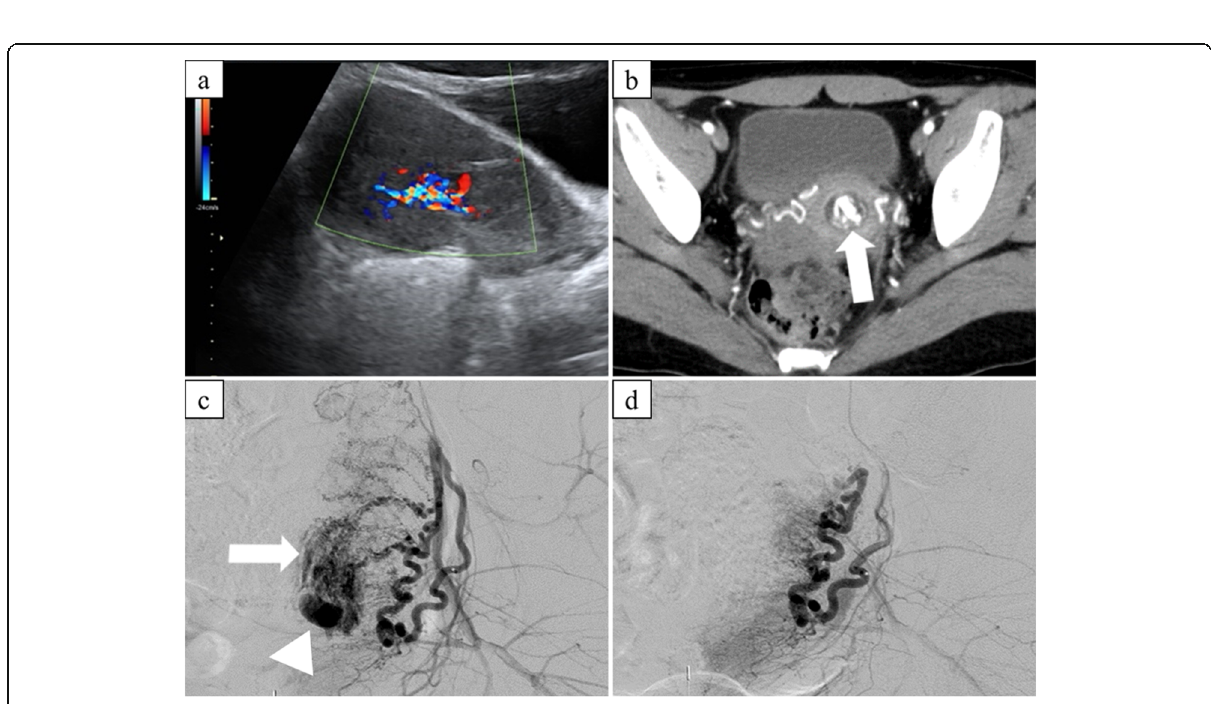
Fig. 2 32-year-old patient with vaginal bleeding post D&C for missed abortion. a Trans-abdominal ultrasonography showing a hypervascular intrauterine mass. b Arterial-phase CE-CT showing an enhancing lesion in the uterine cavity (arrow). c Left uterine arteriogram showing a focal blush (arrow) and a pseudoaneurysm (arrowhead). d Post-embolization left uterine arteriogram confirming the disappearance of the pseudoaneurysm and focal